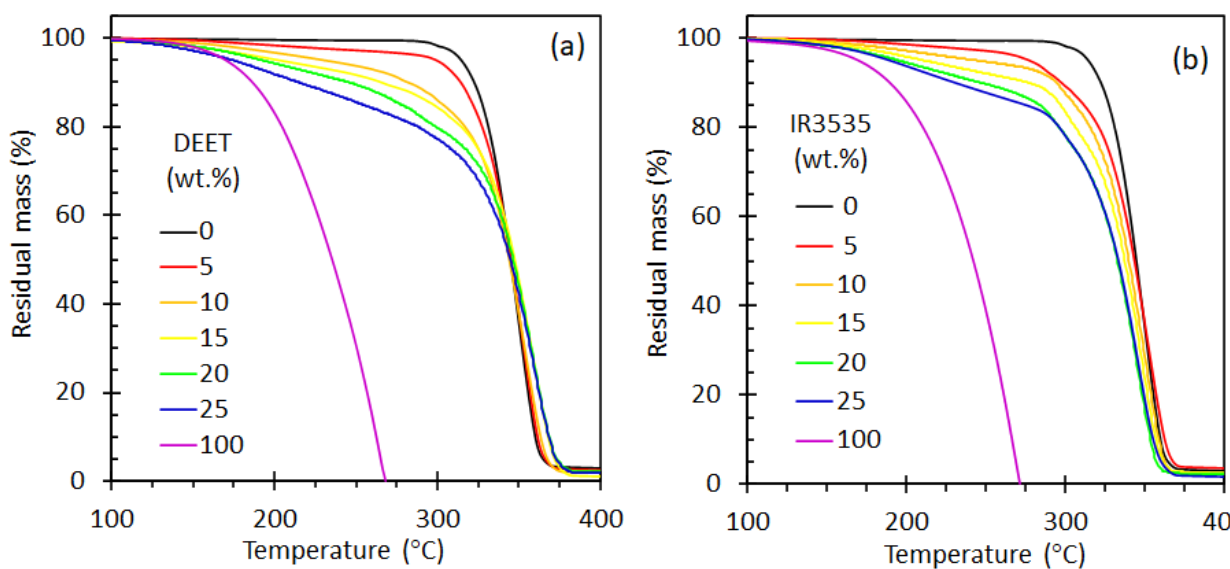
Figure 1. Thermogravimetric plots of: ( a ) neat DEET, neat PLA and PLLA/DEET blends; ( b ) neat IR3535, neat PLA and PLA/IR3535 blends. The legend indicates the nominal repellent contents of the PLA strands.